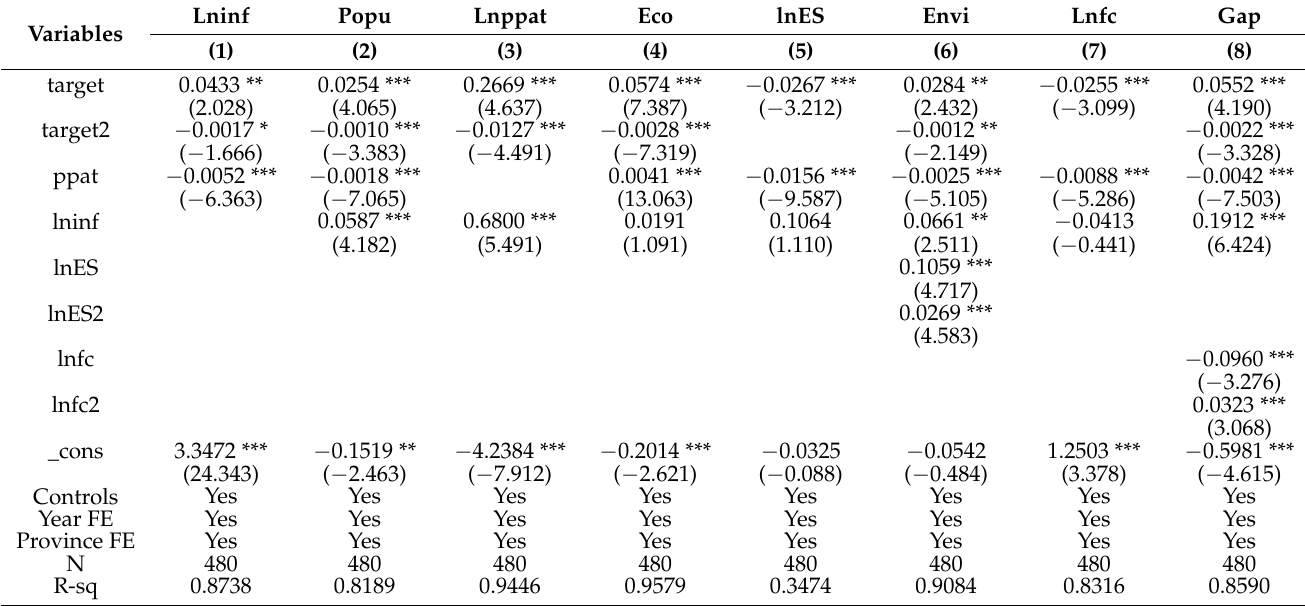
Table 6. Pathway